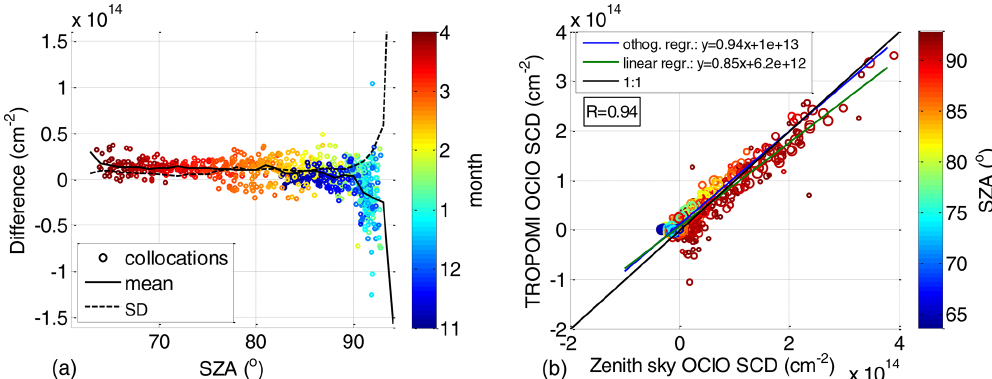
Figure 6. (a) Difference between the collocated TROPOMI measurements and zenith sky DOAS measurements as a function of SZA ( x axis) and the time of the measurement (colour scale). The mean and standard deviation of the data binned in a 1 ◦ SZA grid are indicated by the solid and dashed black lines, respectively. (b) Correlation plot between the TROPOMI and zenith sky measurements. The SZAs of these measurements are colour-coded, while the radius of the circles indicates the number of TROPOMI pixels within the collocated area. Orthogonal and linear regression lines between both datasets and their equations are provided in the